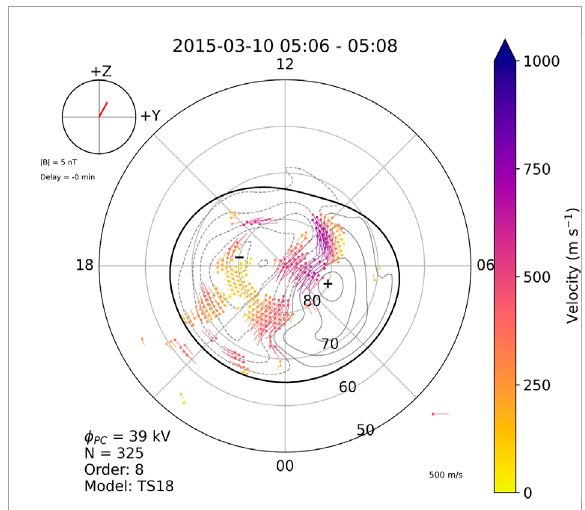
FIGURE 7 Ionospheric convection map with color-coded fitted velocities at 05:06–05:08 UT on 10 March